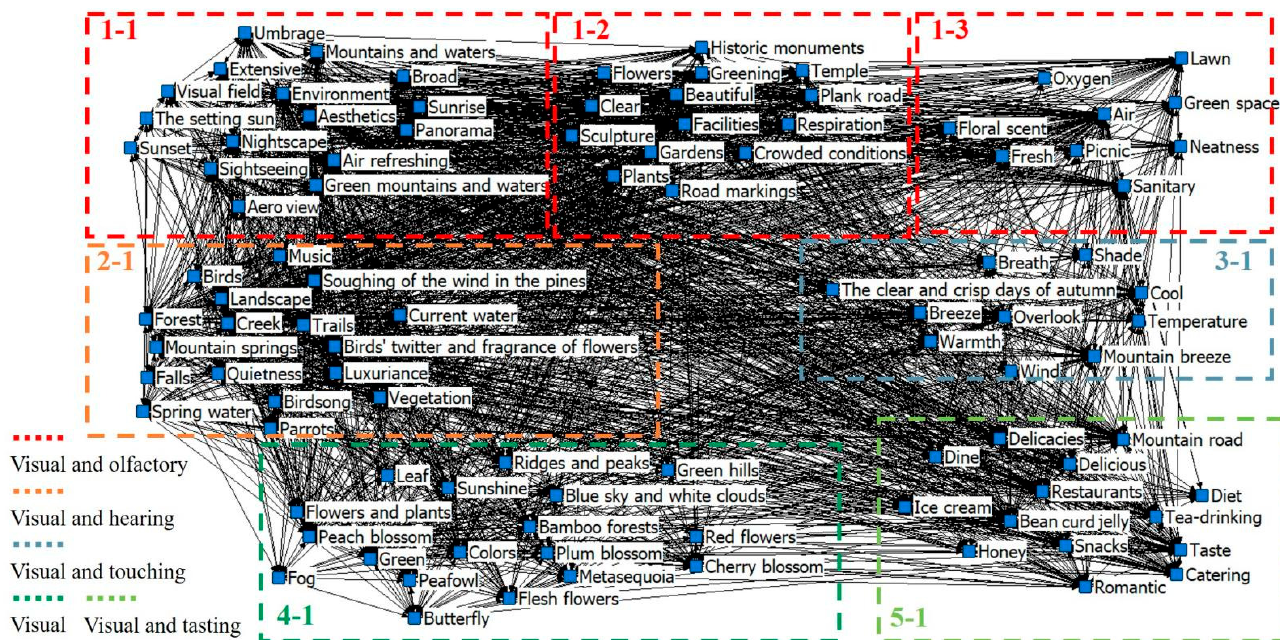
Figure 6. Visualization results of CONCOR analysis.